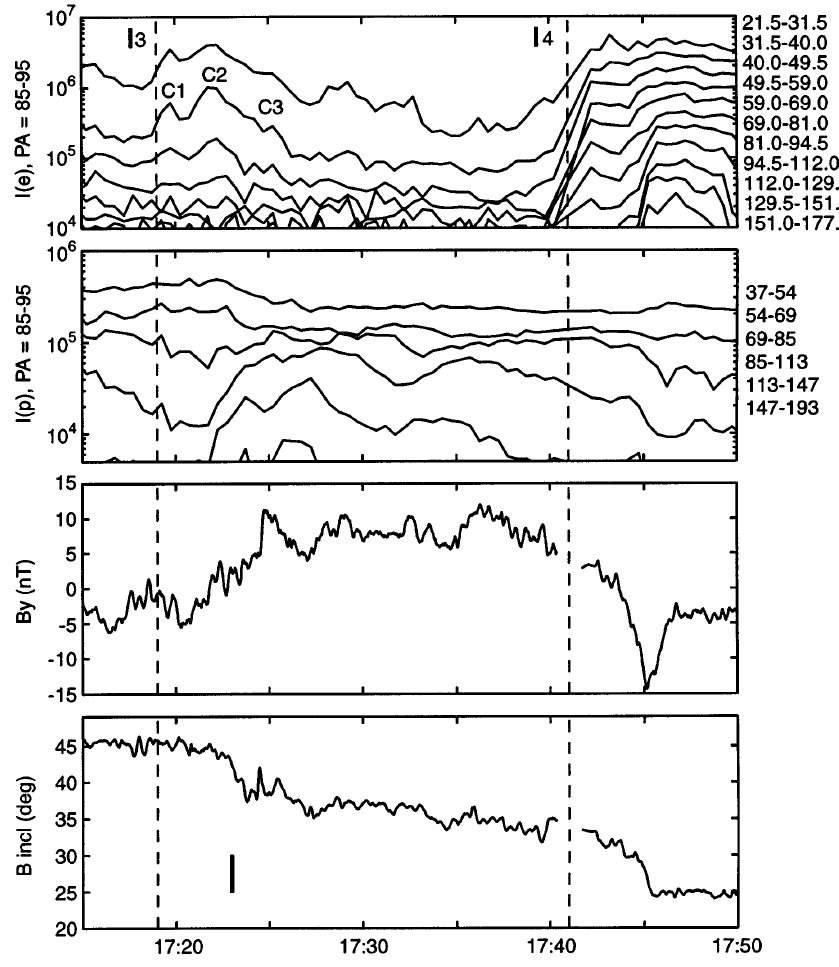
Fig. 5. The third and fourth intensifica- tions. Shown are equatorial (90 (cid:14) PA) electron ( panel 1 ) and proton (cid:133) panel 2 (cid:134) flux intensities at the lowermost energy channels B y ( panel 3 ), and inclination of B (angle between B x and B z , panel 4). Flux intensi- ties are expressed in cm (cid:255) 2 s (cid:255) 1 sr (cid:255) 1 keV (cid:255) 1 : The vertical tick mark in the lowermost panel indicate the interval of increased field line stretching that coincide with the proton